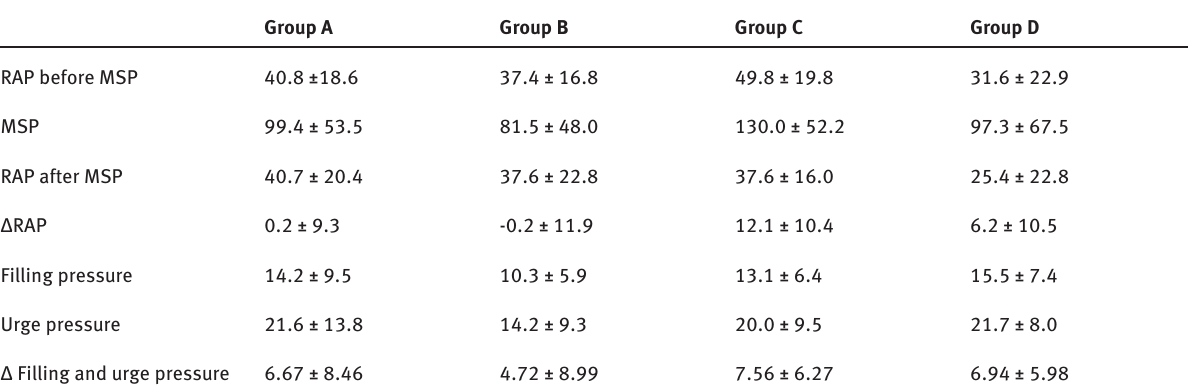
Table 2: Manometry values (mm Hg).